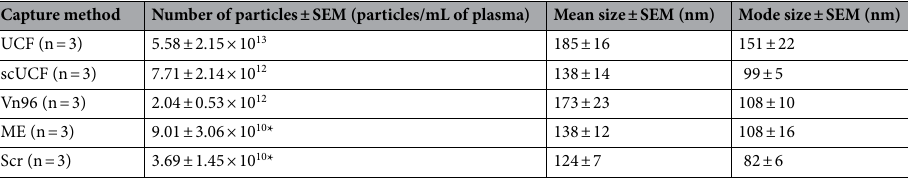
Table 2. NTA using multiple EV capture methods. * P < 0.05.